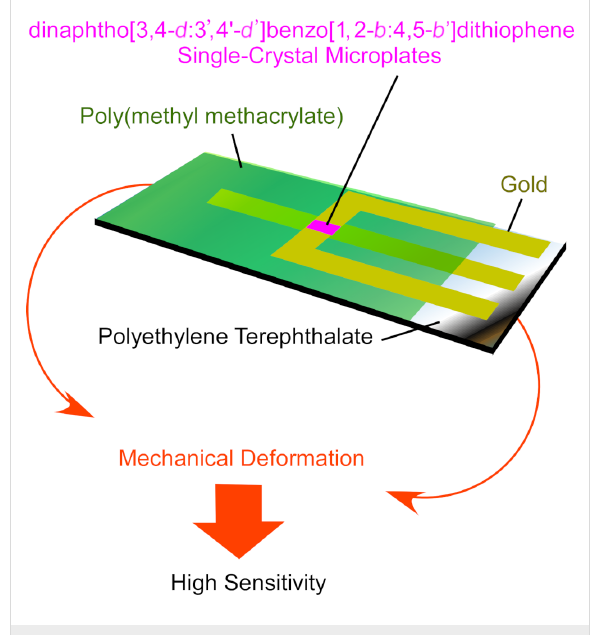
Figure 2: A water-gated bio-organic transistor with odorant binding proteins for the discrimination of chiral